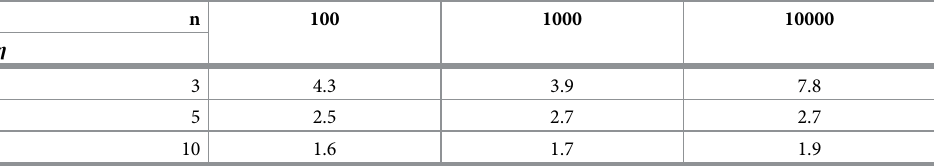
Table 2. Expected tree depth for an attacker fraction of β = 0.05 before deanonymization of the virtual